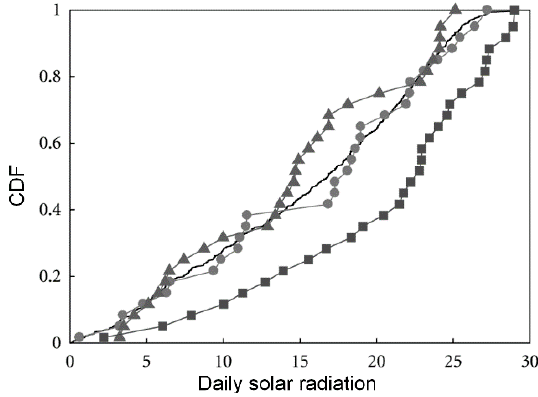
Figure 1. Cumulative Probability Functions (CDFs) of solar radiation in a